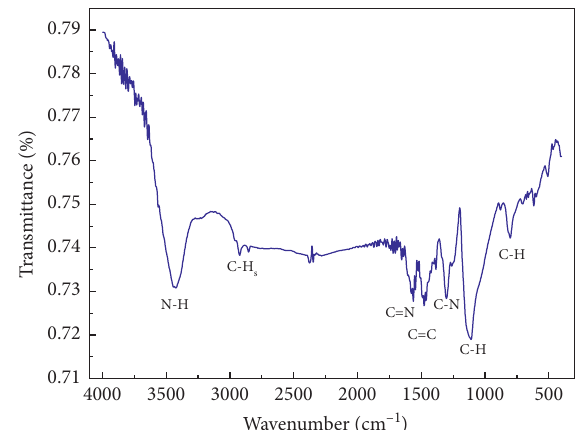
Figure 2: FT-IR spectra of PANI synthesis on the 316L